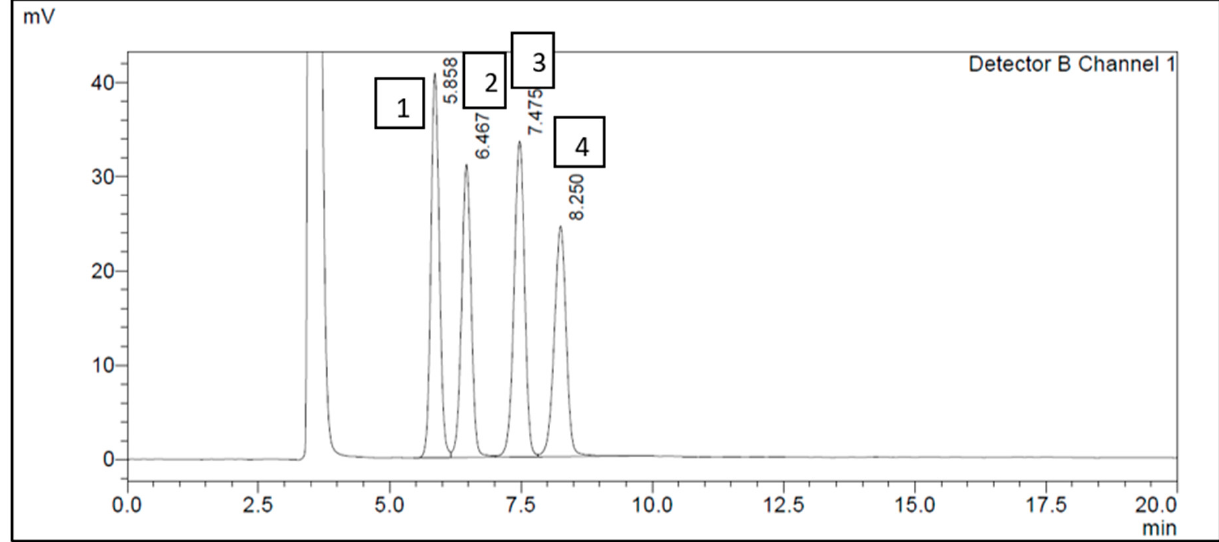
Figure 1. Chromatogram of Standard Sugars: (1) Fructose, (2) Glucose, (3) Sucrose, (4) Lactose.